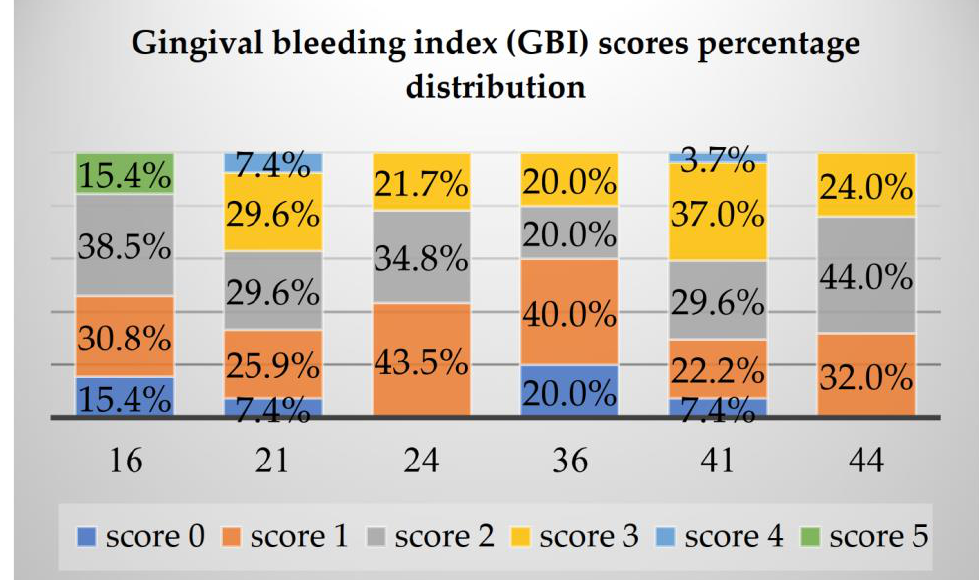
Figure 2. Gingival bleeding index mean score percentage distributions on Ramfjord teeth (teeth numbers 16, 21, 24, 36, 41 and 44).